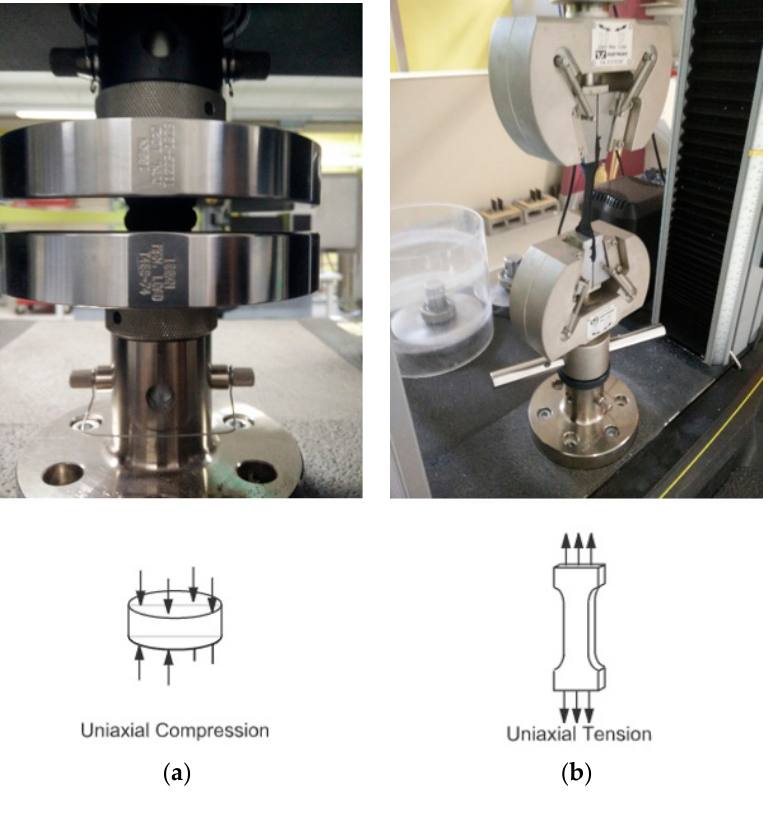
Figure 5. Material testing of EPDM rubber used for Gasket: ( a ) Uniaxial Compression; ( b ) Uniaxial